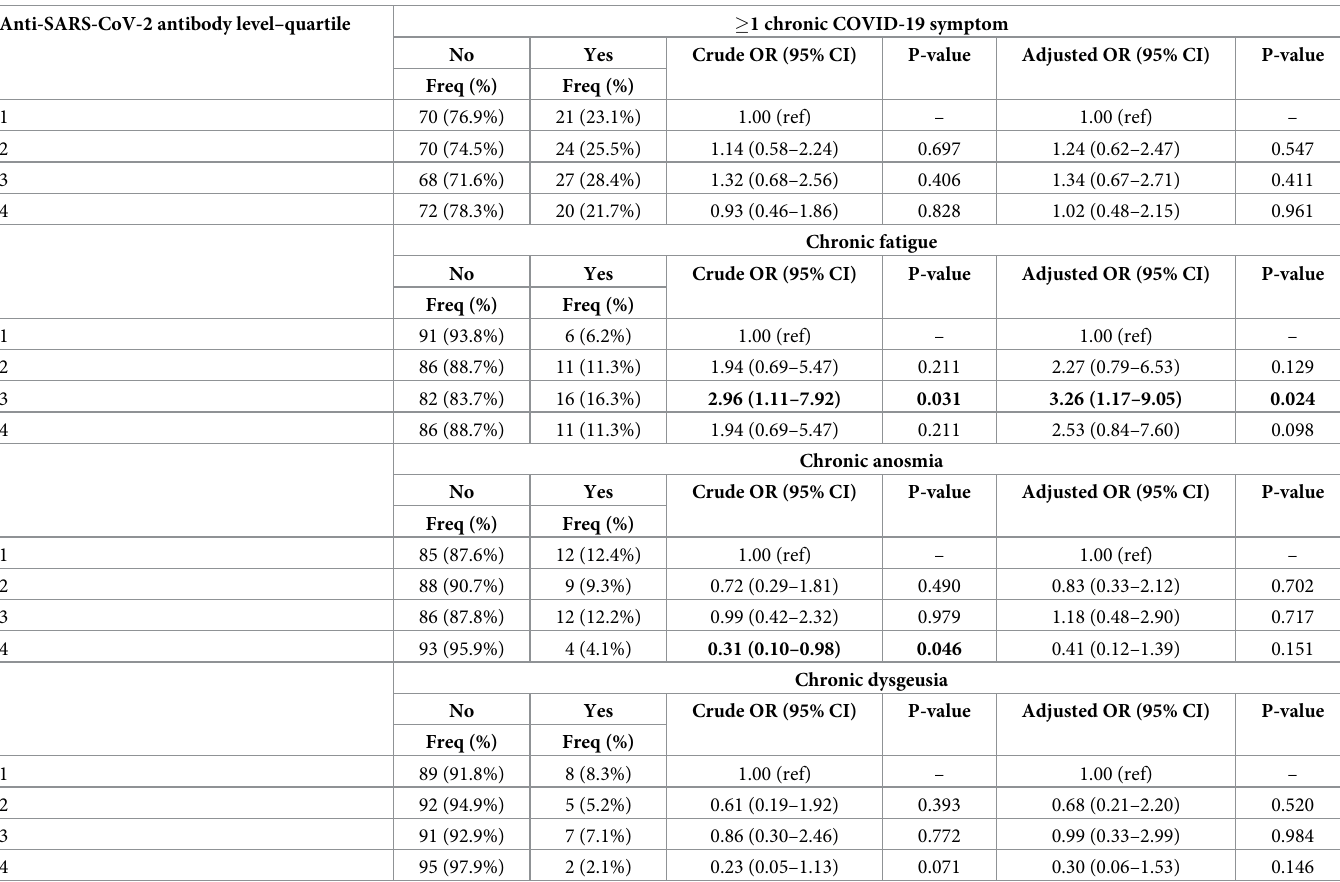
Table 5. Associations of anti-SARS-CoV-2 antibody levels with any chronic COVID-19 symptom, particularly chronic fatigue, anosmia and dysgeusia. Anti-SARS-CoV-2 antibody level–quartile � 1 chronic COVID-19